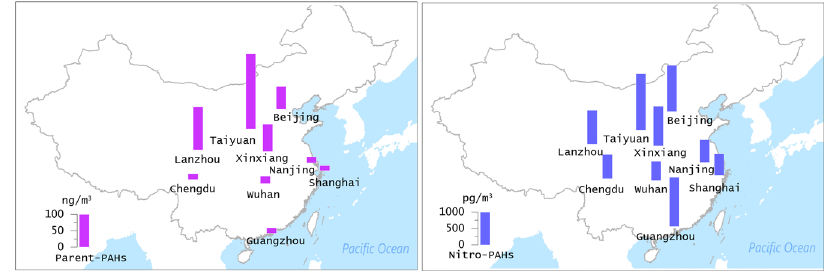
Figure 1. Spatial distributions of the concentration of parent PAHs and nitro-PAHs in PM2.5 from 9 urban cities. (the background map was made using surfer 8.0 by one